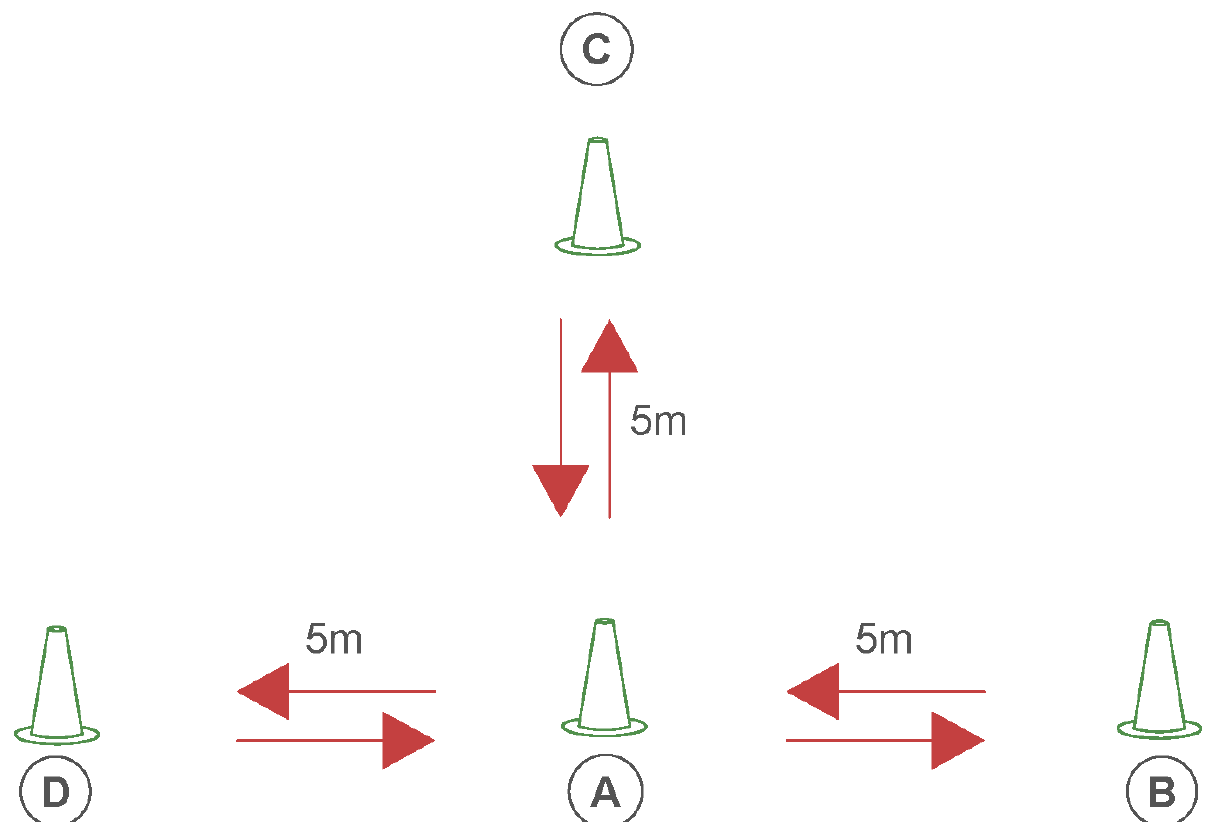
Figure 12. Experimental repeated-sprint ability (RSA5COD Agility Test) and Multi-direction repeated sprint ability (RSM); adapted and edited from [37] .